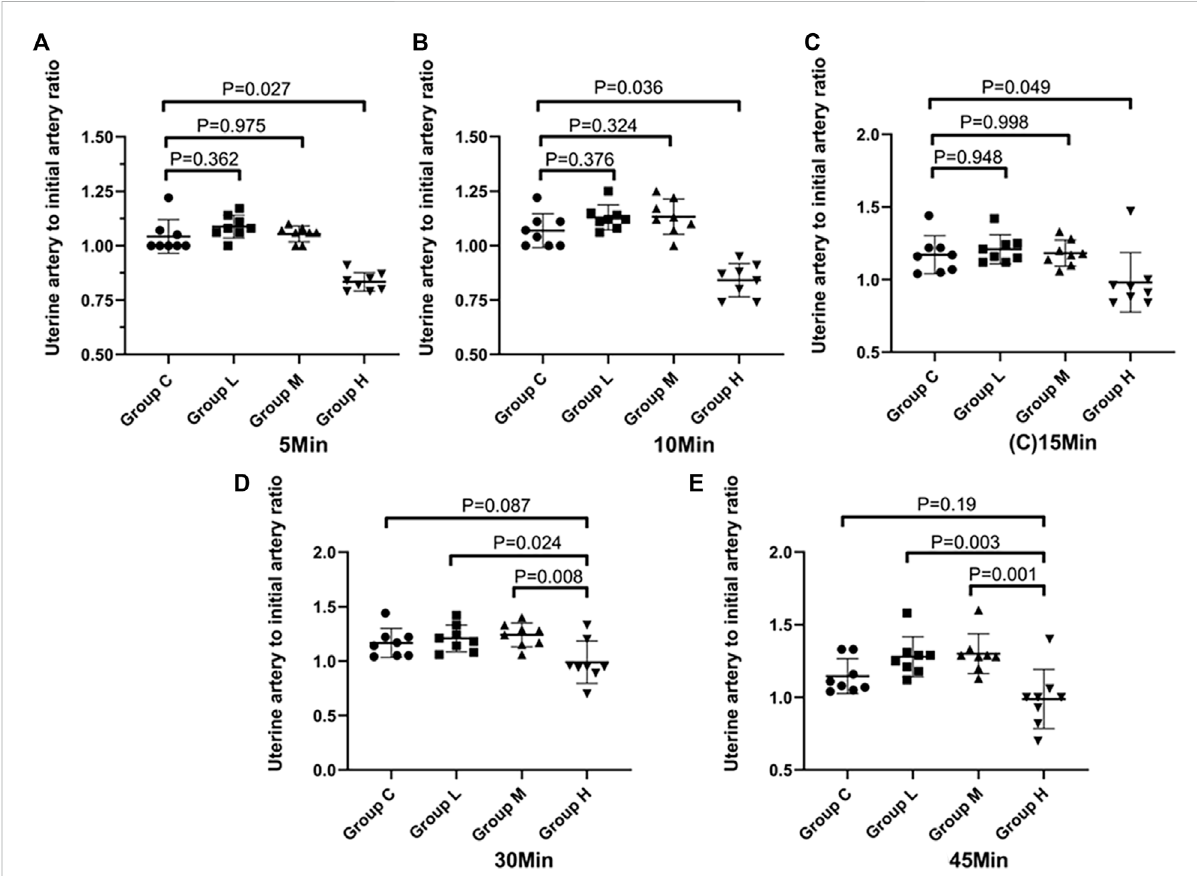
FIGURE 4 Distribution of the ratio of the diameter of the uterine artery to the initial diameter at different time points. The black line is used to link two groups with statistical signi fi